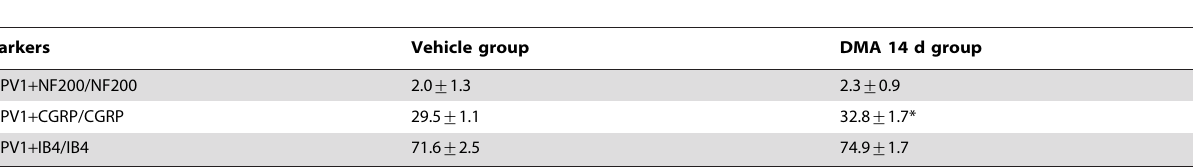
Table 2. Double labeling rate of TRPV1 immunoreactivity with that of NF200, CGRP or IB4 in DRG neurons (n =4–6).